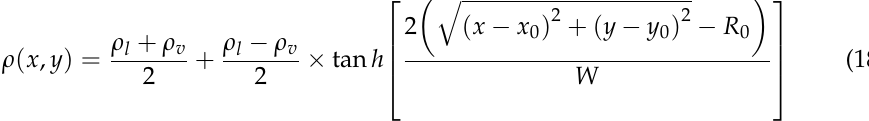
Figure 8. Time evolution of Minkowski measures for the collapsing bubble near a solid wall with complex geometry. ( a ) the whole process from = t 0 to = t 800 ts , ( b ) the part process from = t 680 ts to = t 780 ts .